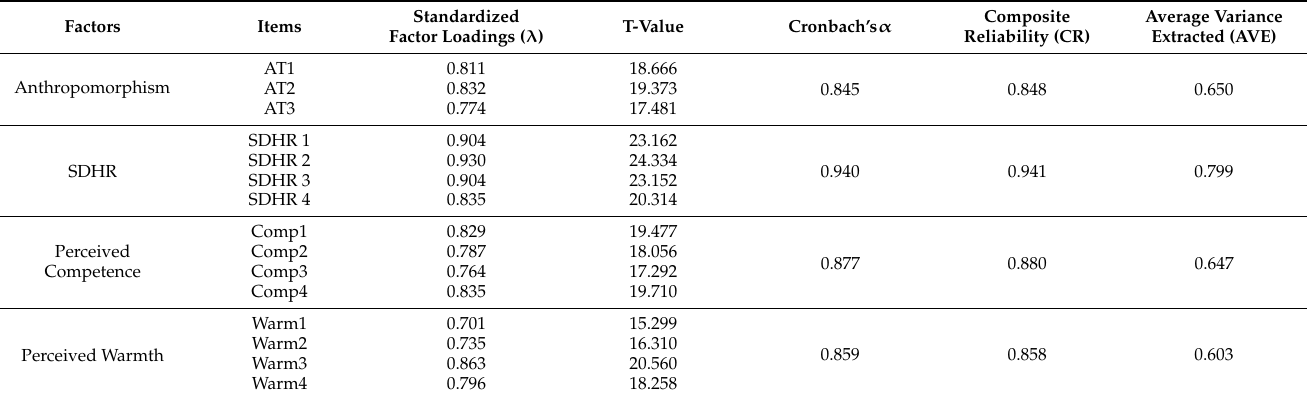
Table 3. Results of reliability and validity analysis.